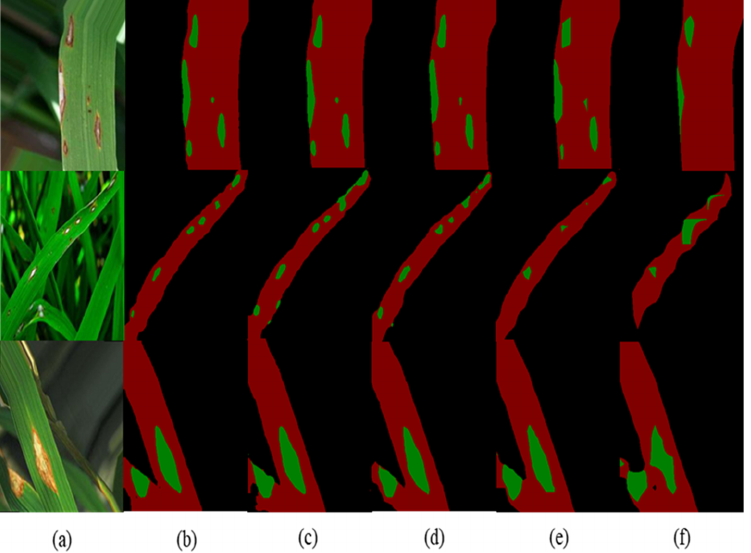
Figure 6. Segmentation effect of rice blast disease: ( a ) original image of disease spot; ( b ) segmentation effect of the DCABlock + FFM1 + FFM2 + FFM3 + Attention model; ( c ) segmentation effect of the DCABlock + FFM1 + FFM2 + FFM3 model; ( d ) segmentation effect of the DCABlock + FFM1 + FFM2 model; ( e ) the DCABlock + FFM1 model segmentation effect; ( f ) the DCABlock model segmentation effect.